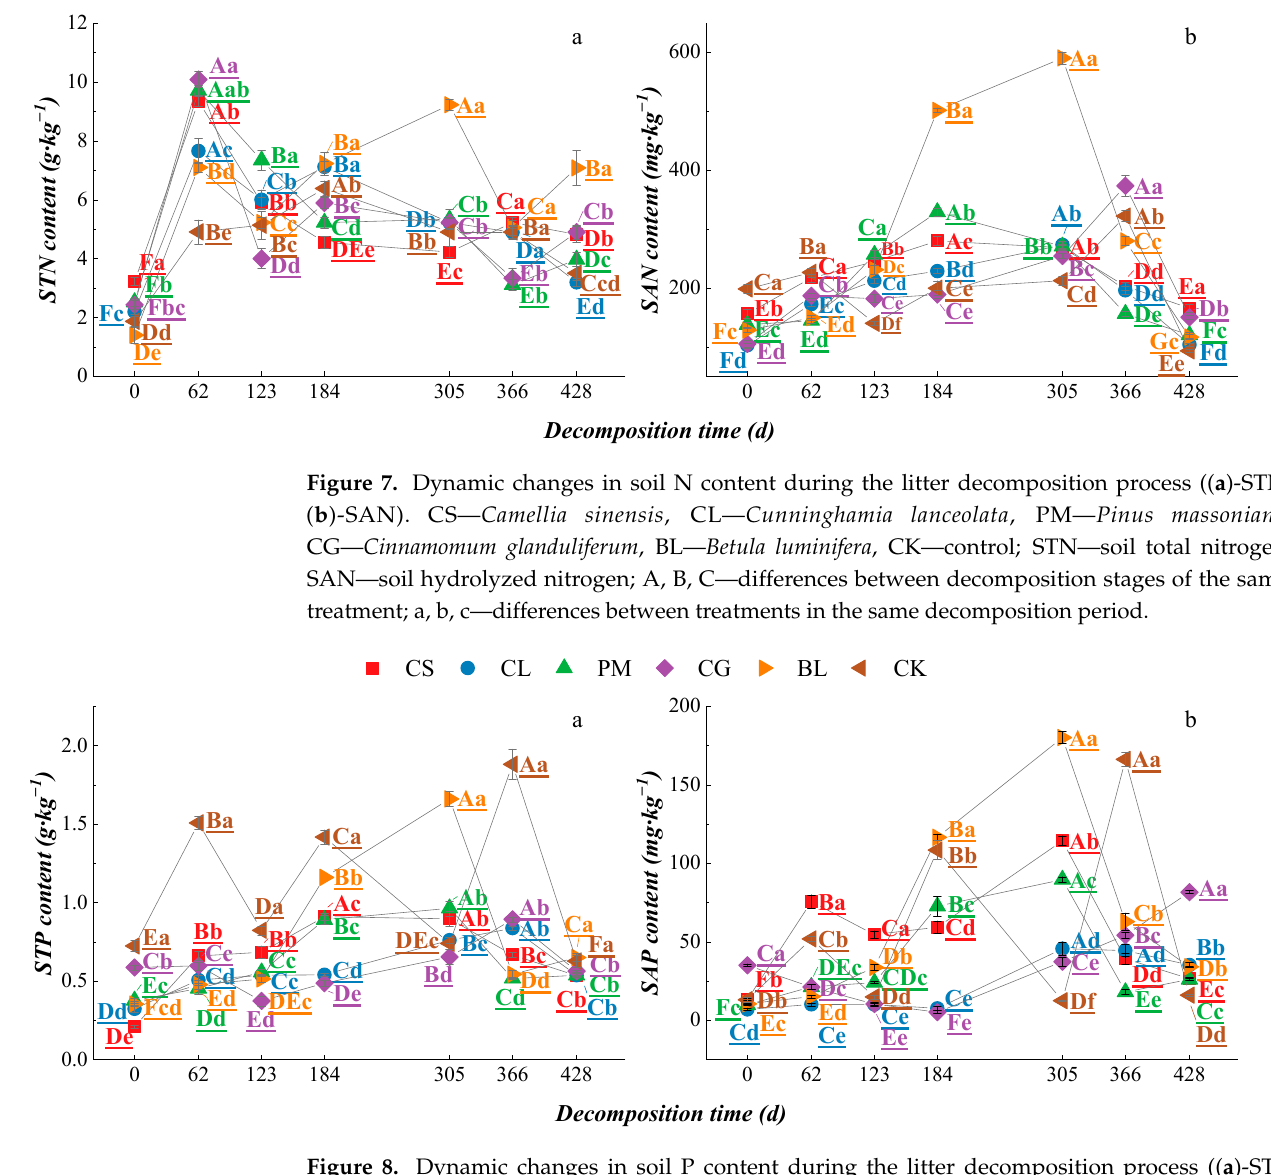
Figure 8. Dynamic changes in soil P content during the litter decomposition process (( a )-STP, ( b )-SAP). CS— Camellia sinensis , CL— Cunninghamia lanceolata , PM— Pinus massoniana , CG— Cin- namomum glanduliferum , BL— Betula luminifera , CK—control; STP—soil total phosphorus, SAP—soil available phosphorus; A, B, C—differences between decomposition stages of the same treatment; a, b, c—differences between treatments in the same decomposition period.